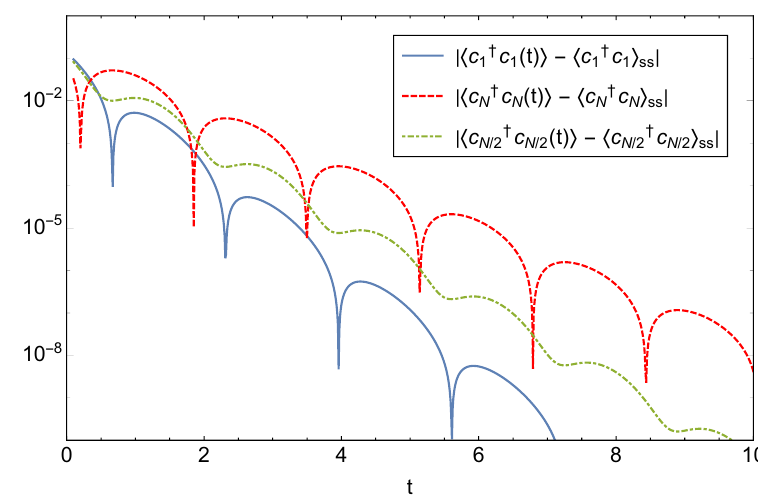
Figure 3: Approach to the steady state value of local occupation numbers at the left edge (blue, solid), right edge (red, dashed) and center (green, dash- dot) of the dissipative Kitaev chain with OBC. The absolute value is shown on a semi-log scale, in order to highlight the exponentially decaying envelopes and their different decay rates, caused by the presence of topological edge